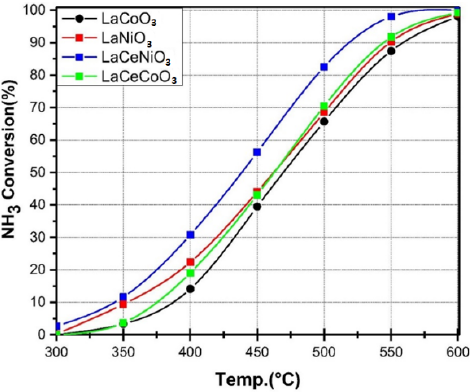
Figure 33. Comparison performance of lanthanum-based catalysts for ammonia decomposition. Reprinted with permission [130].